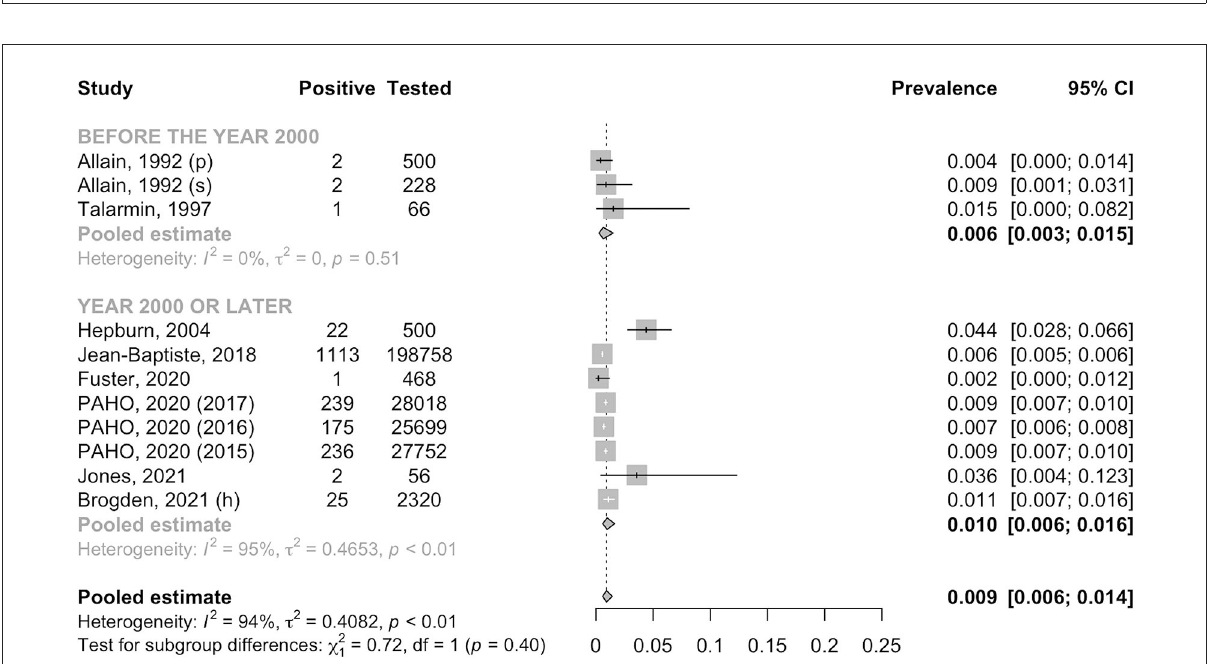
FIGURE7 Prevalence of anti-HCV antibody in the general adult population by year. h, hospital recruitment; p, pregnant women; PAHO, Pan American Health Organization; s, surgery patient.